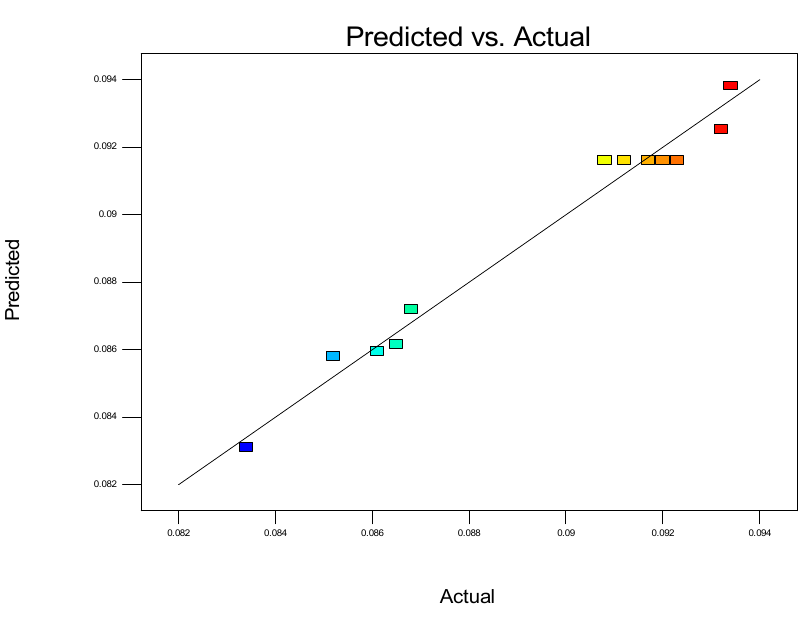
Figure 7. The predicted vs. the actual COF for the MoS 2 nanolubricants.